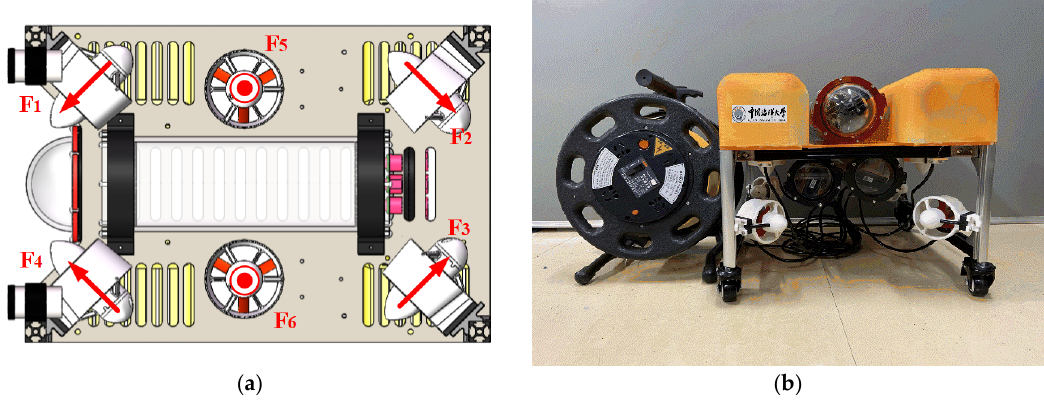
Figure 3. Model of “Lingrui” ROV: ( a ) 3D model with thruster arrangement; ( b ) physical model. Table 1. The ROV-designed specifications.